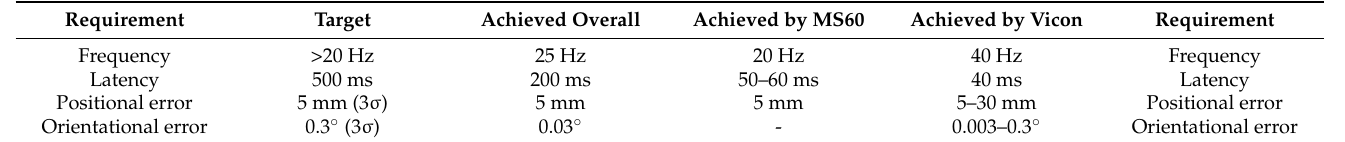
Table 1. List of requirements.